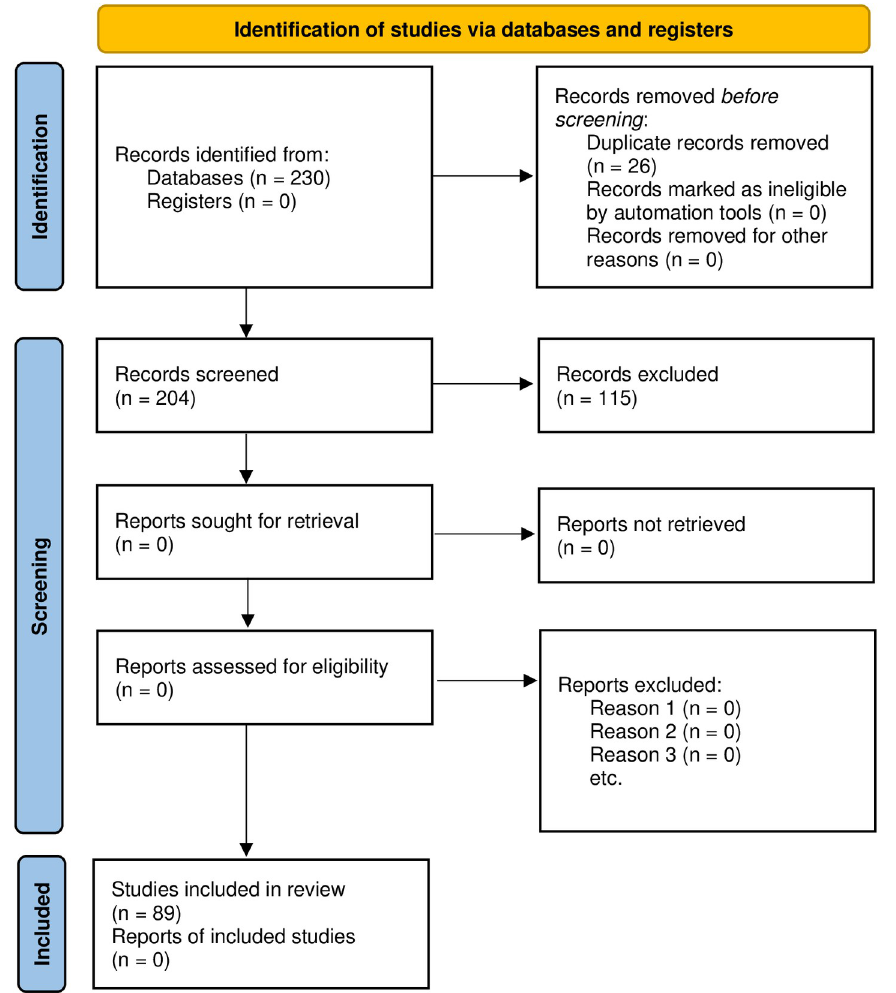
Fig 1. PRISMA flowchart for the identification, screening, and inclusion of